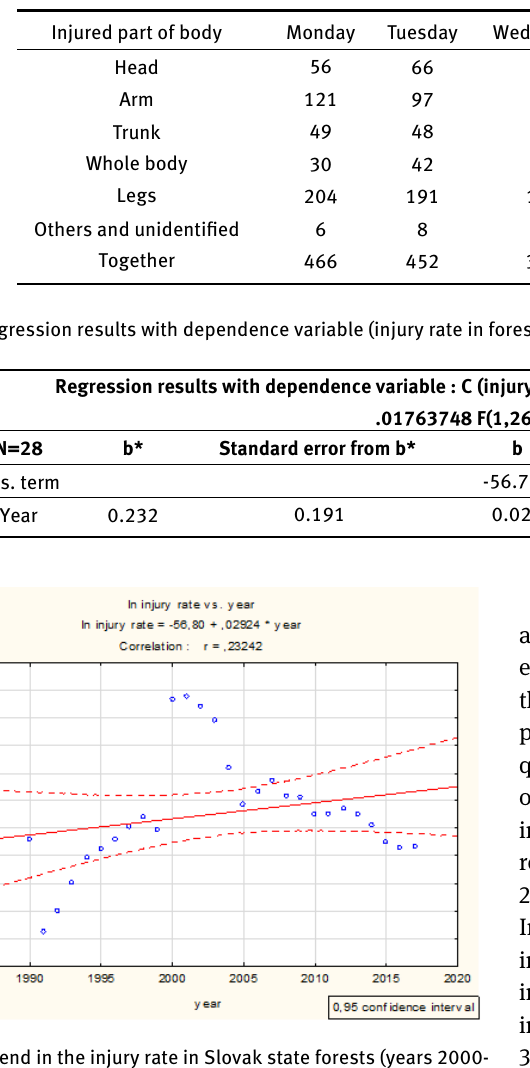
Table 1: Number of injuries according to part of body and days in week in State forestry enterprise (years 2000-2017